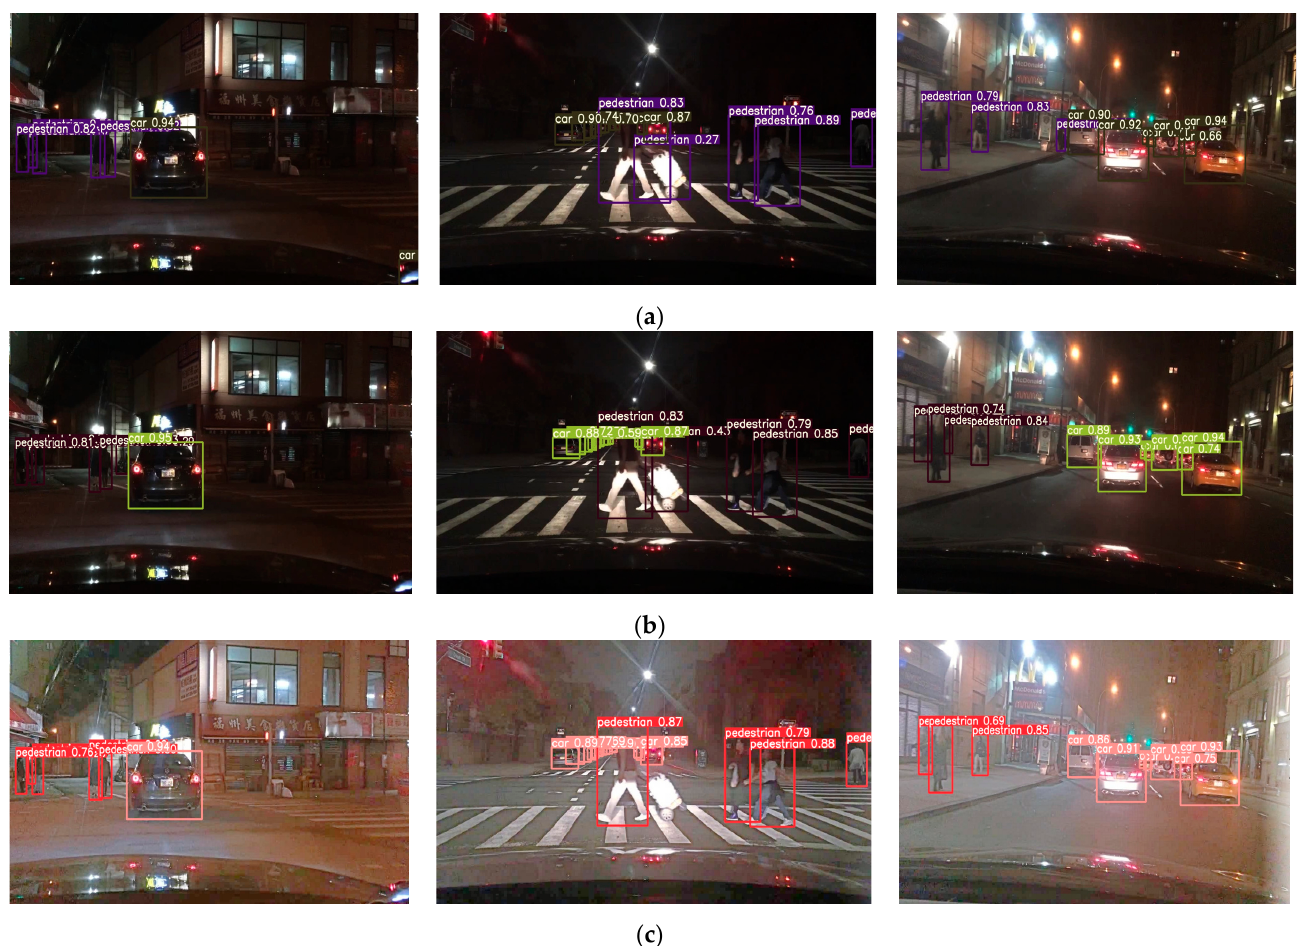
Figure 7. Comparison of detection results under the night scenario. ( a ) YOLOX; ( b ) improved YOLOX (ours); ( c ) improved YOLOX + Domain Transfer (ours).